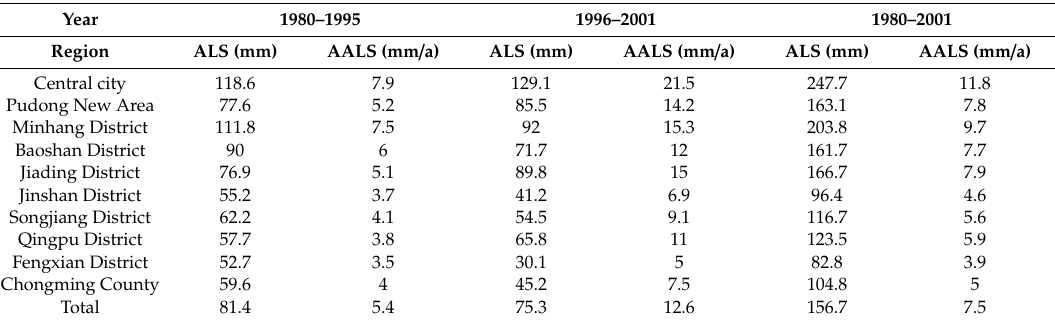
Table 7. Statistical analysis of land subsidence regions in